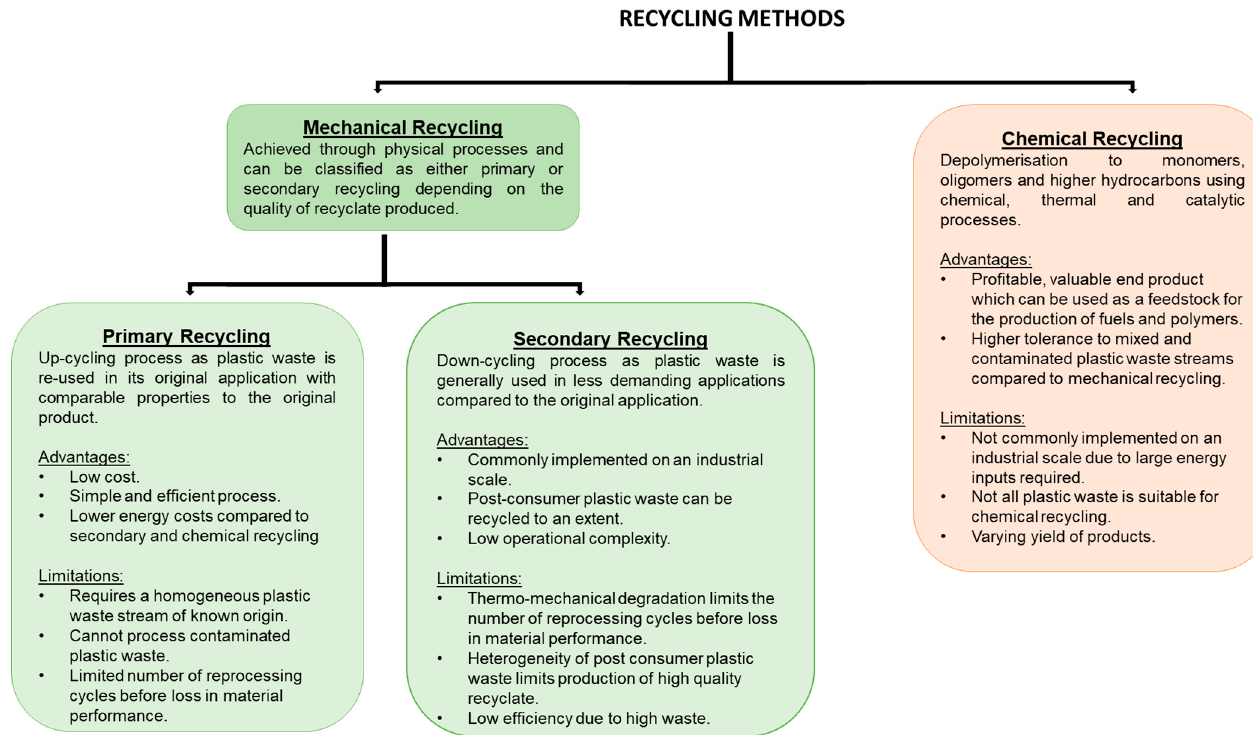
Figure 2. A summary of the advantages and limitations of mechanical and chemical recycling [17,18,39,41,46–51].